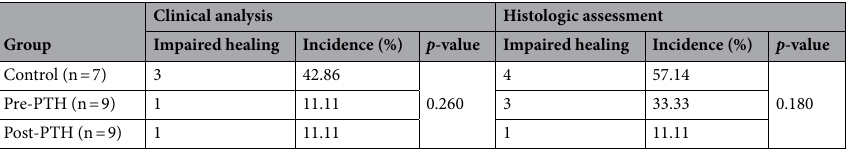
Table 1. Incidence of medication-related osteonecrosis of the jaw (MRONJ) development. Administration of intermittent PTH seemed to have a positive effect on extraction socket healing both in Pre-PTH and Post-PTH